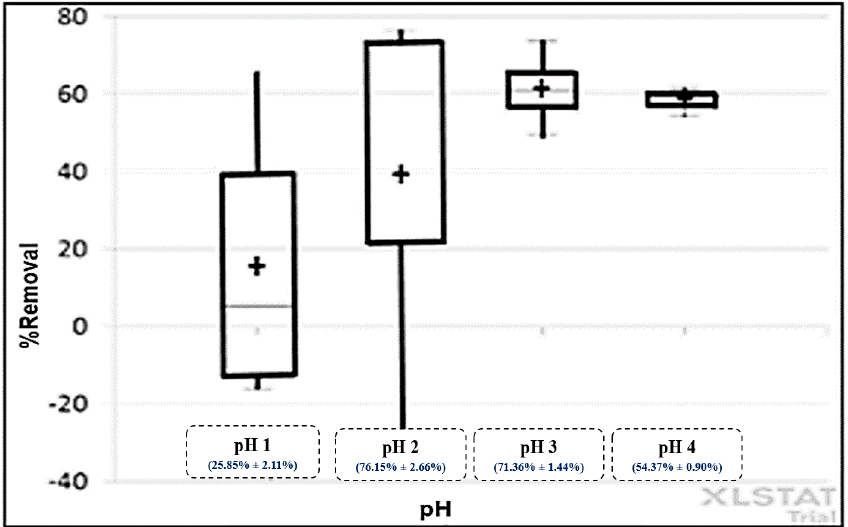
Figure 2. Boxplot of optimum pH for removal of Pb(II) with CP obtained with XLSTAT software.